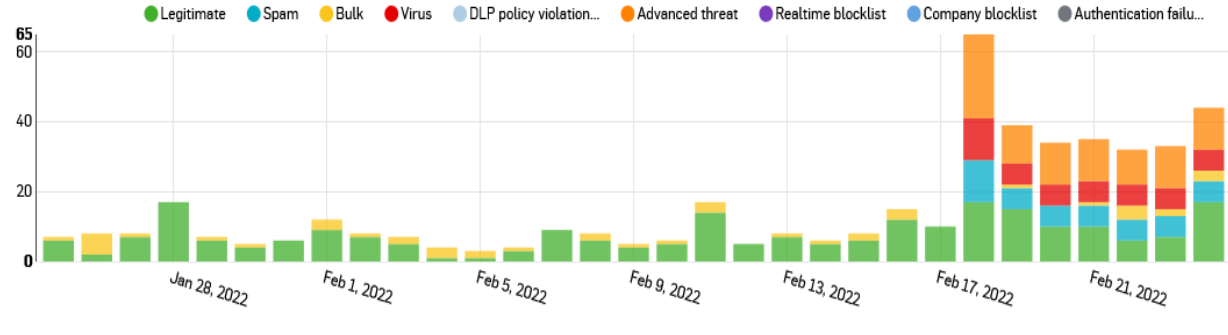
Figure 17. Email log review.